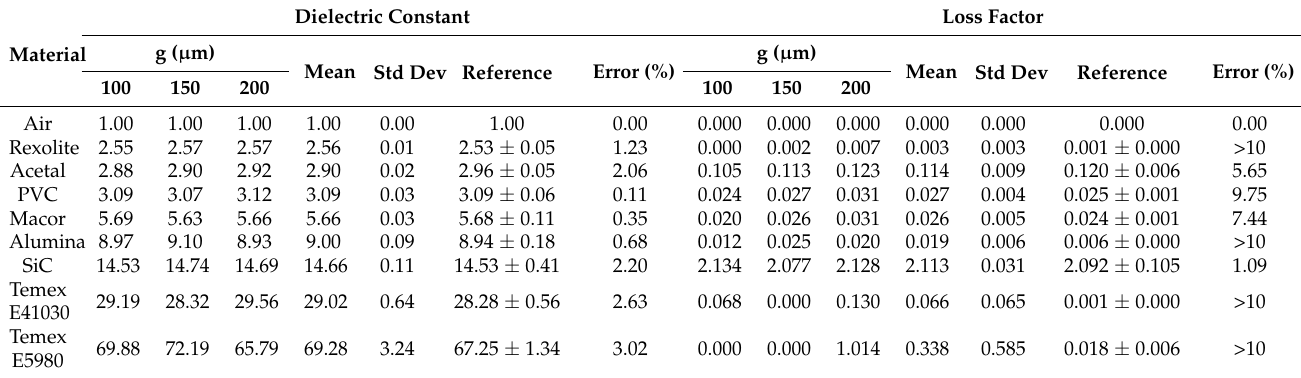
Table 2. Dielectric properties: results of reference materials and associated standard